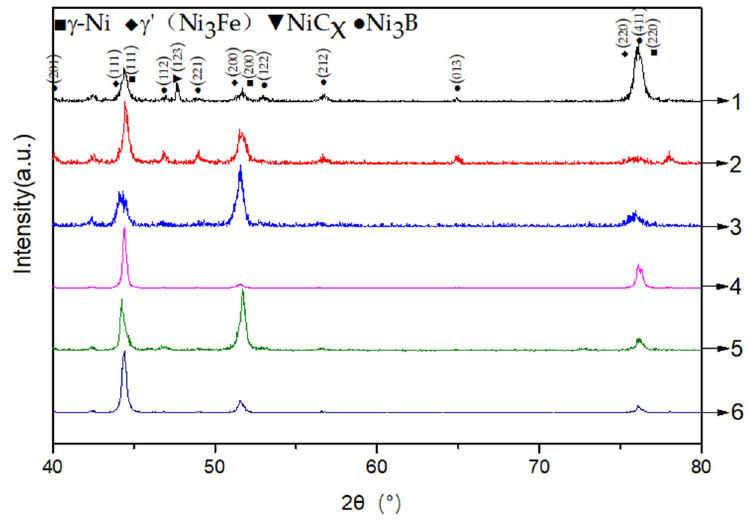
Figure 11. Diffraction patterns of 6 groups of single tracks. Figure 11. Di ff raction patterns of 6 groups of single